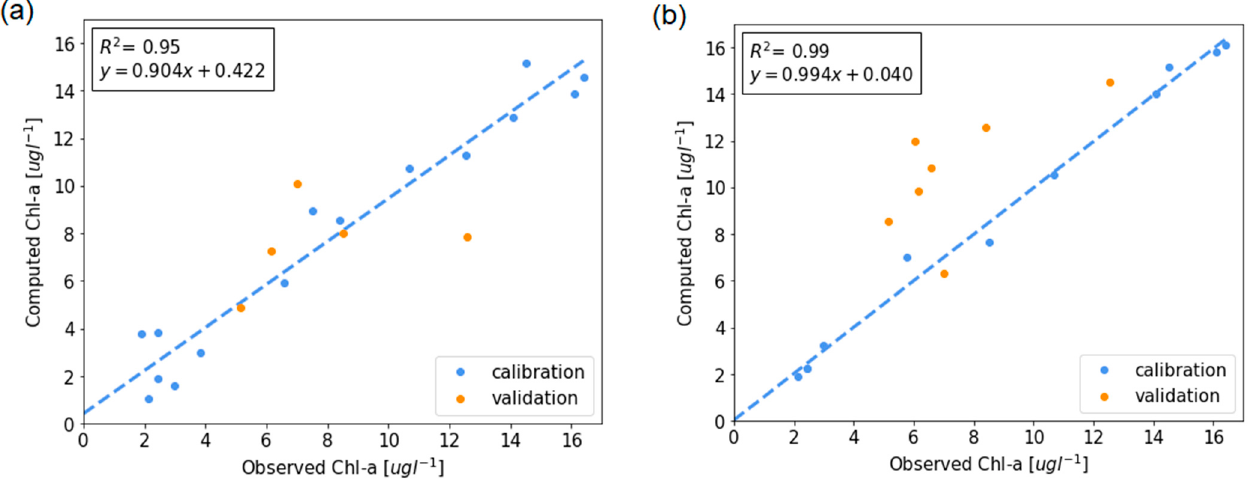
Figure 5. Computed vs. observed Chl-a concentrations for the spring-summer period, with the maxi- mum recorded concentrations excluded: ( a ) Chl-a calculated using TOA data (L1C) and ( b ) Chl-a calculated using BOA data (L2A). Dashed lines correspond to the perfect agreement between com- puted and observed Chl-a concentrations.